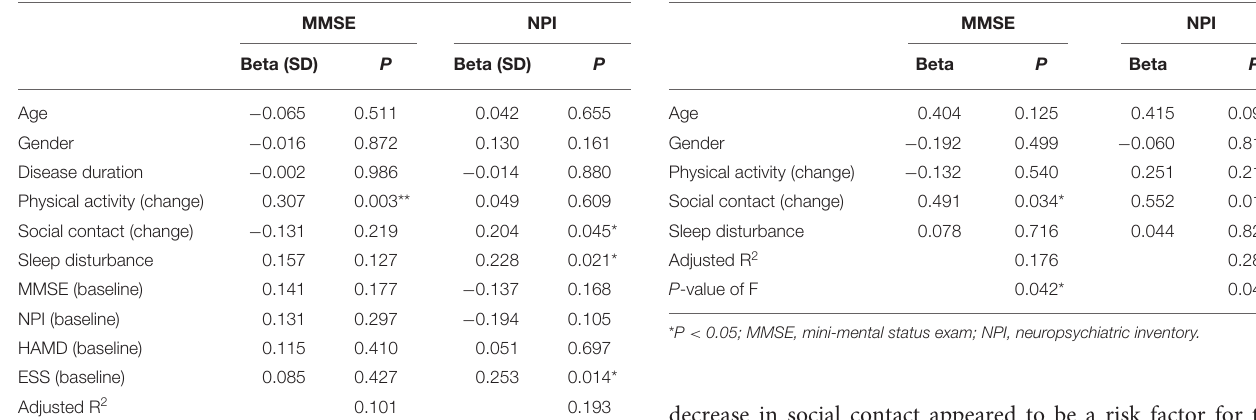
TABLE 4 | Multiple linear regression analysis of cognitive and neuropsychiatry changes in Alzheimer’s Disease.